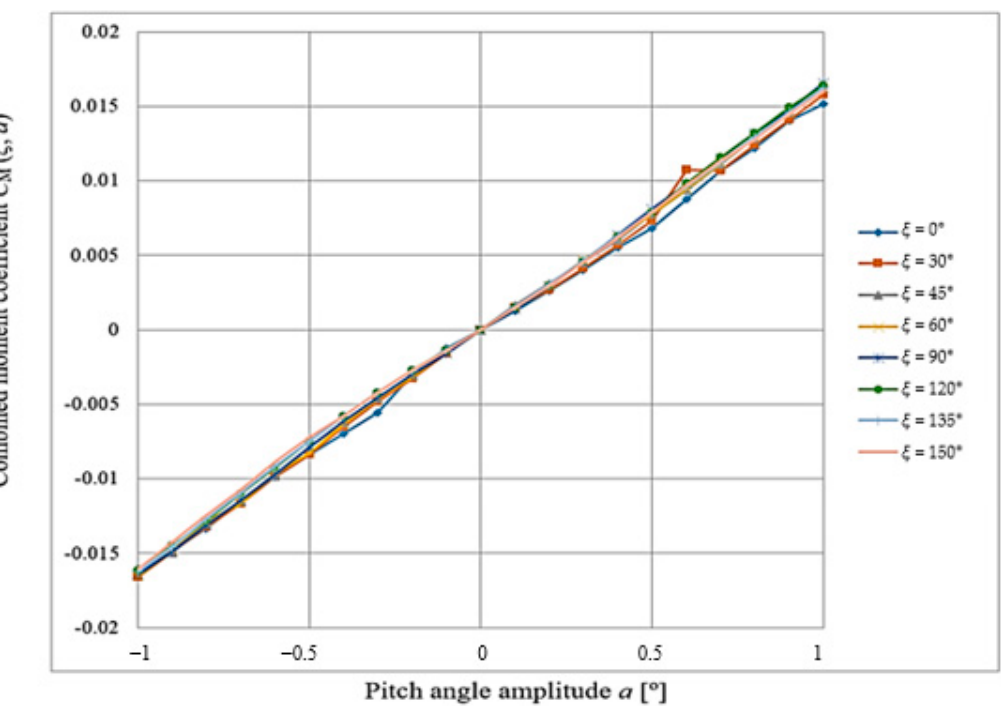
Figure 12. Relation between the combined moment and the pitch-angle amplitude with the angle